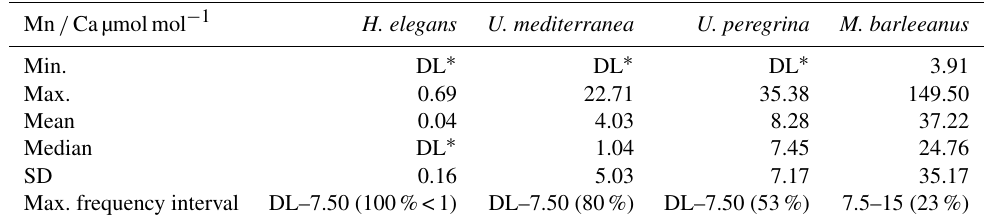
Table 3. Descriptive statistics (minimum, maximum, mean, median, standard deviation, and interval of maximum frequency of total analyses for H. elegans , U. mediterranea , U. peregrina , and M. barleeanus for Mn / Caµmolmol − 1